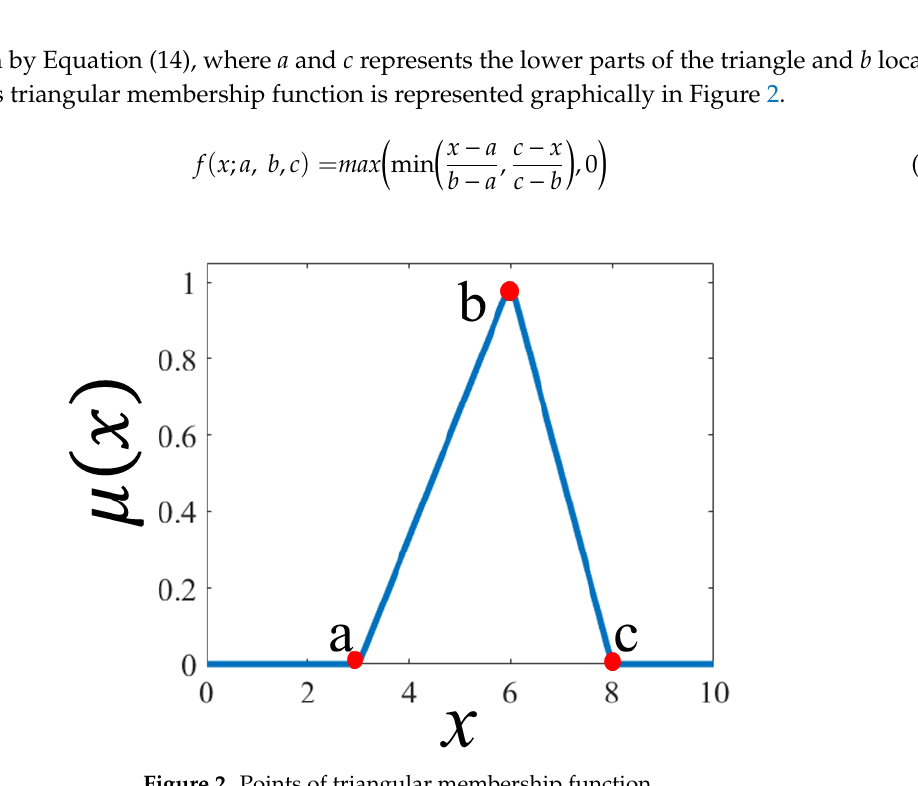
Figure 2. Points of triangular membership function.